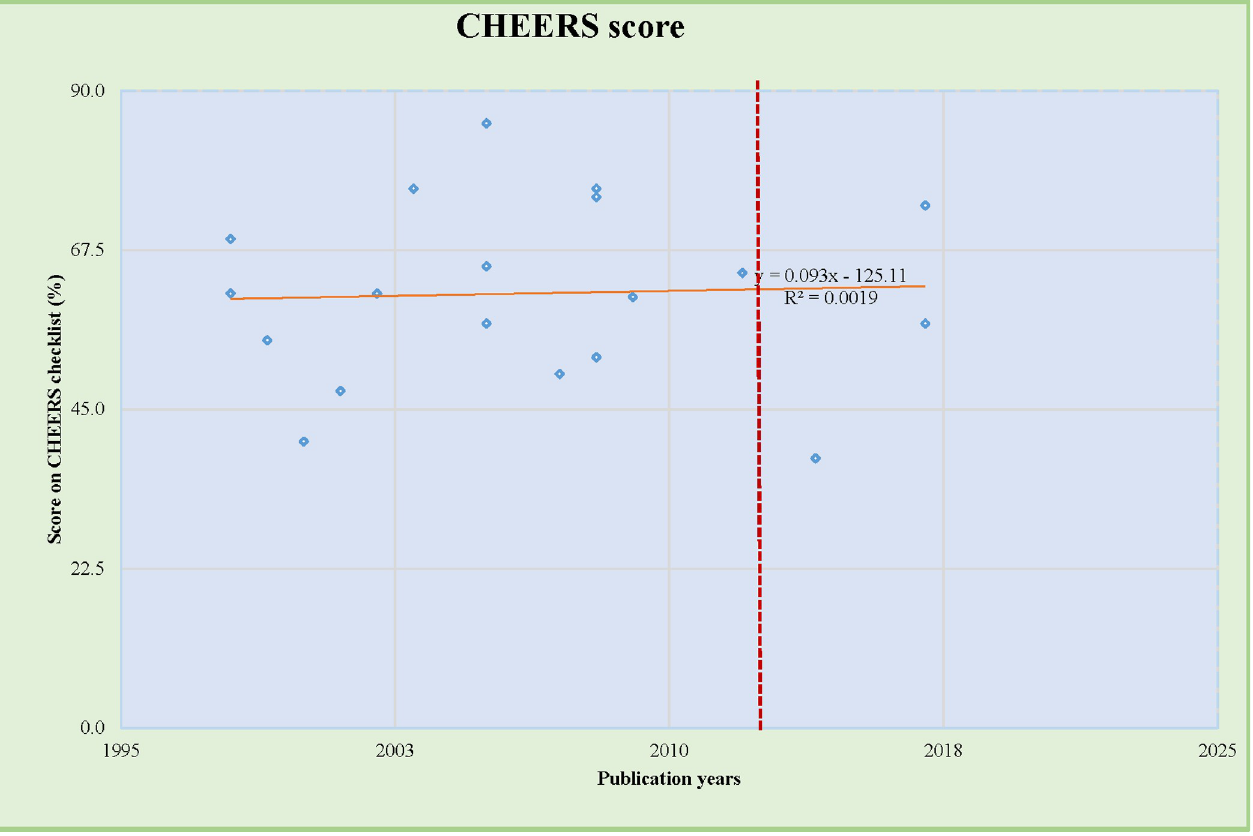
Fig 3. CHEERS score and the trend based on publication